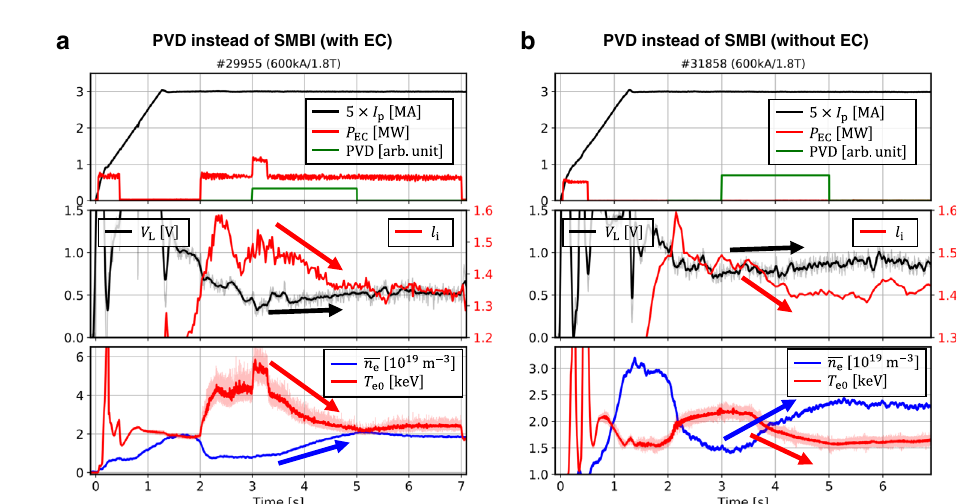
Fig. 3 | Overview of main parameters. #29955 ( a ) and #31858 ( b ), where anomalous currents were also observed. Here, gas fueling at the diverter region by the piezoelectric valve at D-port (PVD) was used instead of supersonic molecular beam injection (SMBI). The discharge, #31858 is a pure Ohmic discharge without